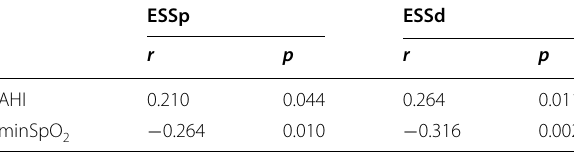
Table 2 Correlations of ESSp and ESSd with the OSA parameters